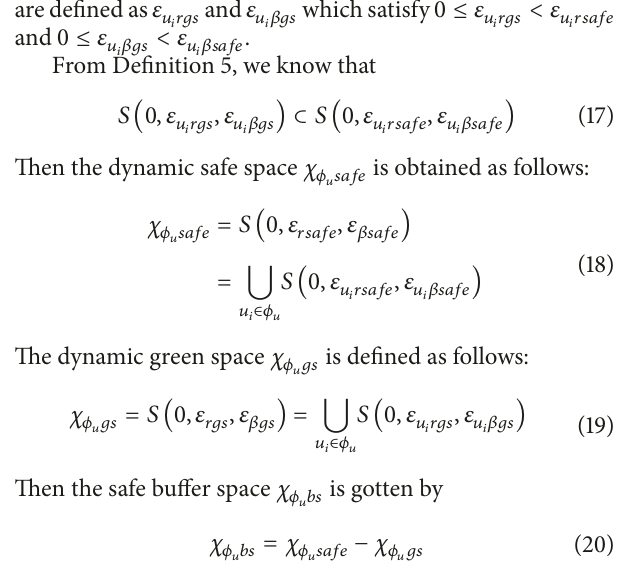
Figure 3. If the speed of ACV exceeds 𝑉 max , the motion of turning is not allowed. If the speed is lower than 0.2𝑉 max , the TR and SA are not required to be limited. The inside space of green boundary is green space. The inside space of yellow boundary is safe space. The space between green boundary and yellow boundary is buffer